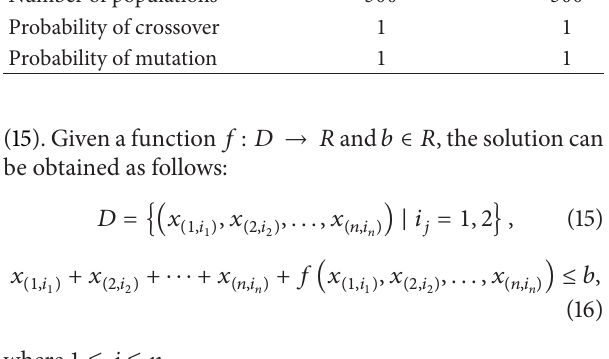
Table 2: Technology of system parameters. GA GHO Number of chromosomes 100000 100000 Number of populations 500 500 Probability of crossover 1 1 Probability of mutation 1